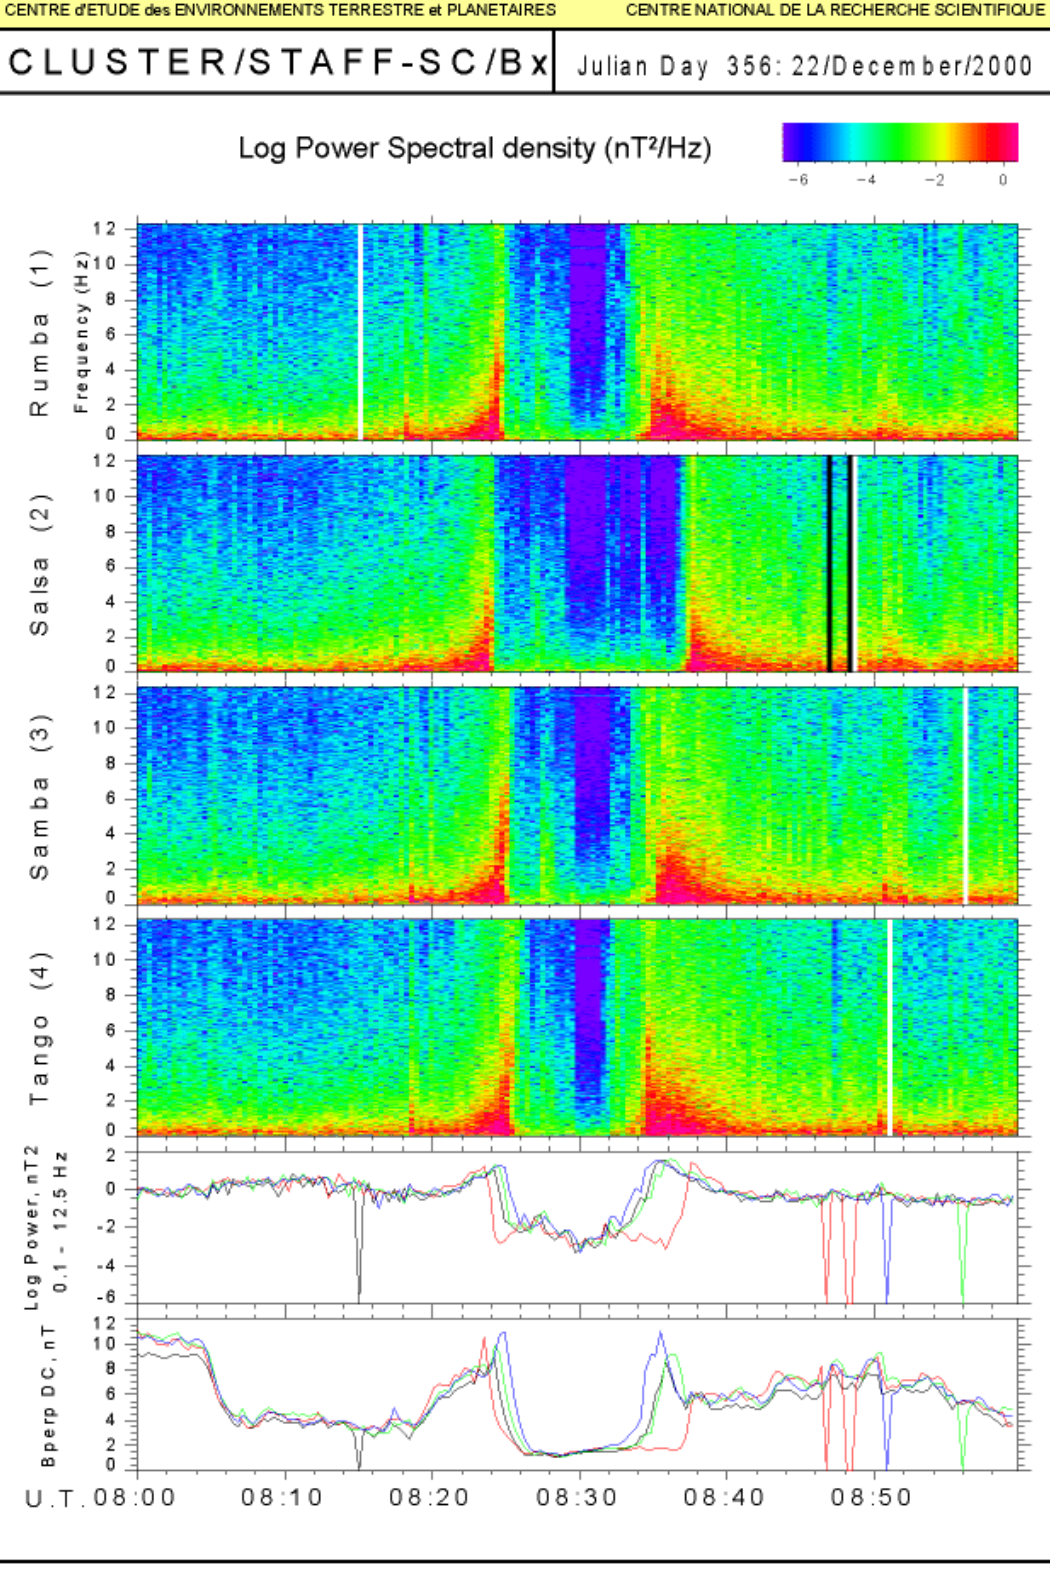
Fig. 9. Low frequency dynamic spectra of the four Cluster for the 2 successive bow shock crossings around 08:30 on 22 December 2000. Same as Fig. 3d, enlarged. The difference in timing is quite